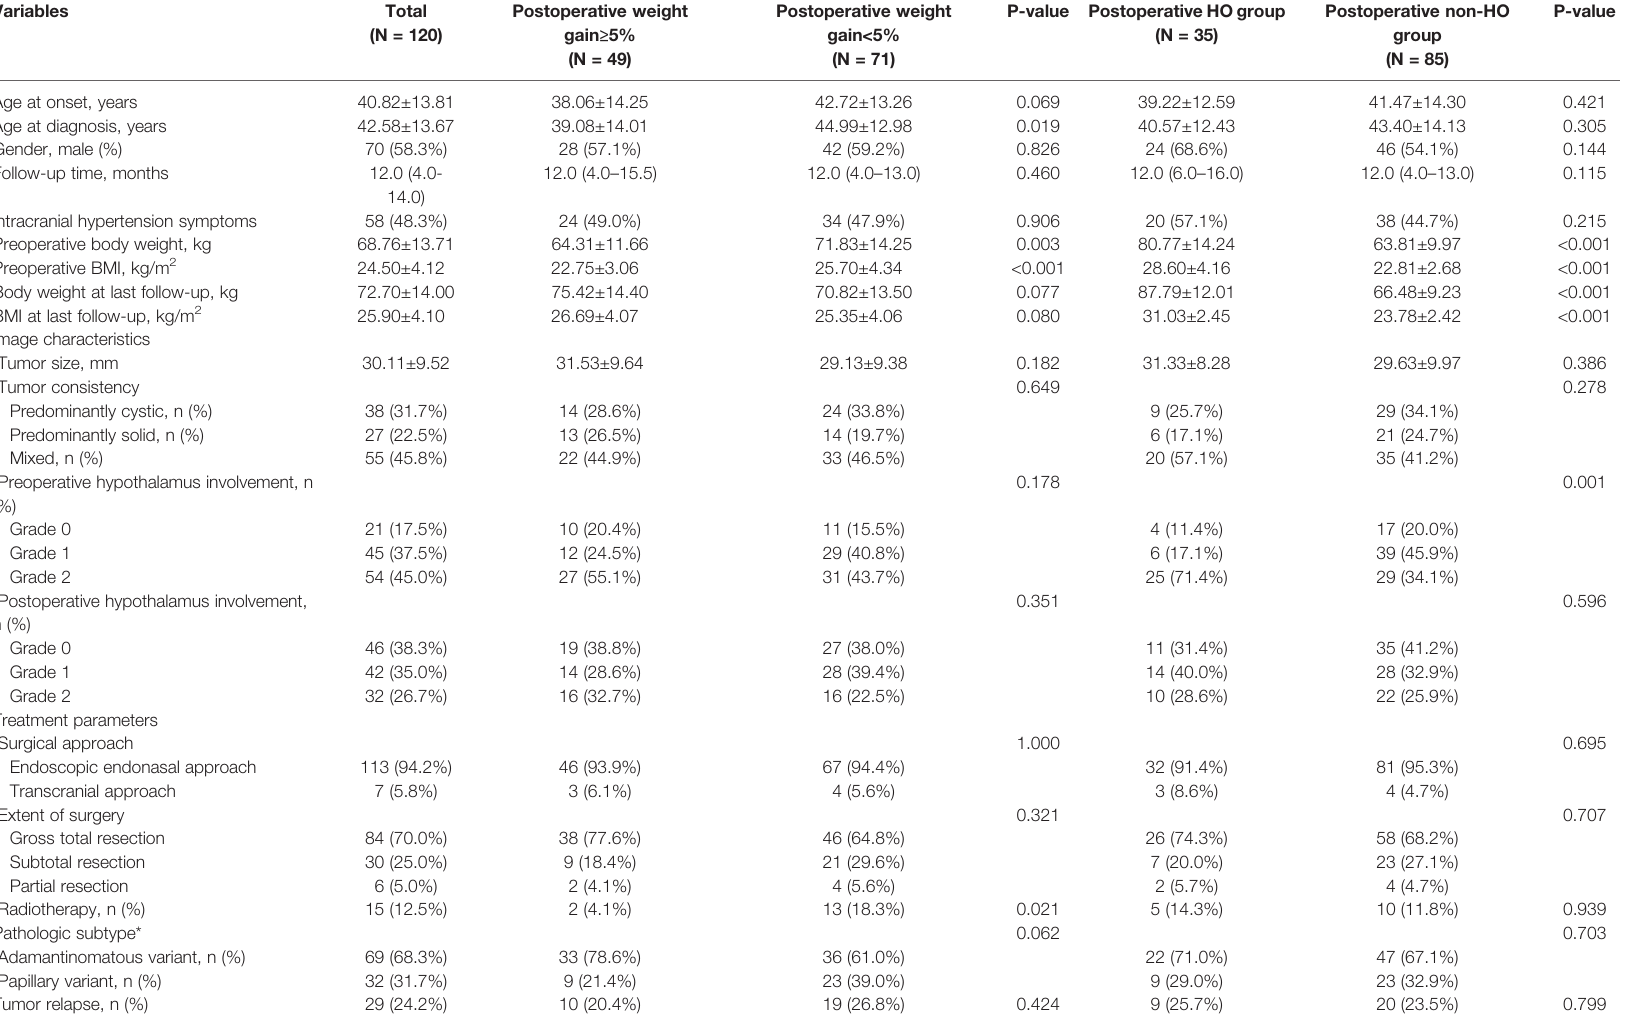
TABLE 1 | General characteristics of 120 adult patients with craniopharyngioma, 2018 –